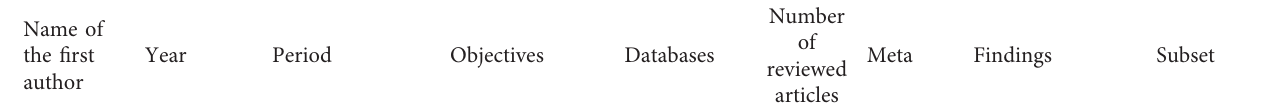
Table 1: Summaries of the main points of the